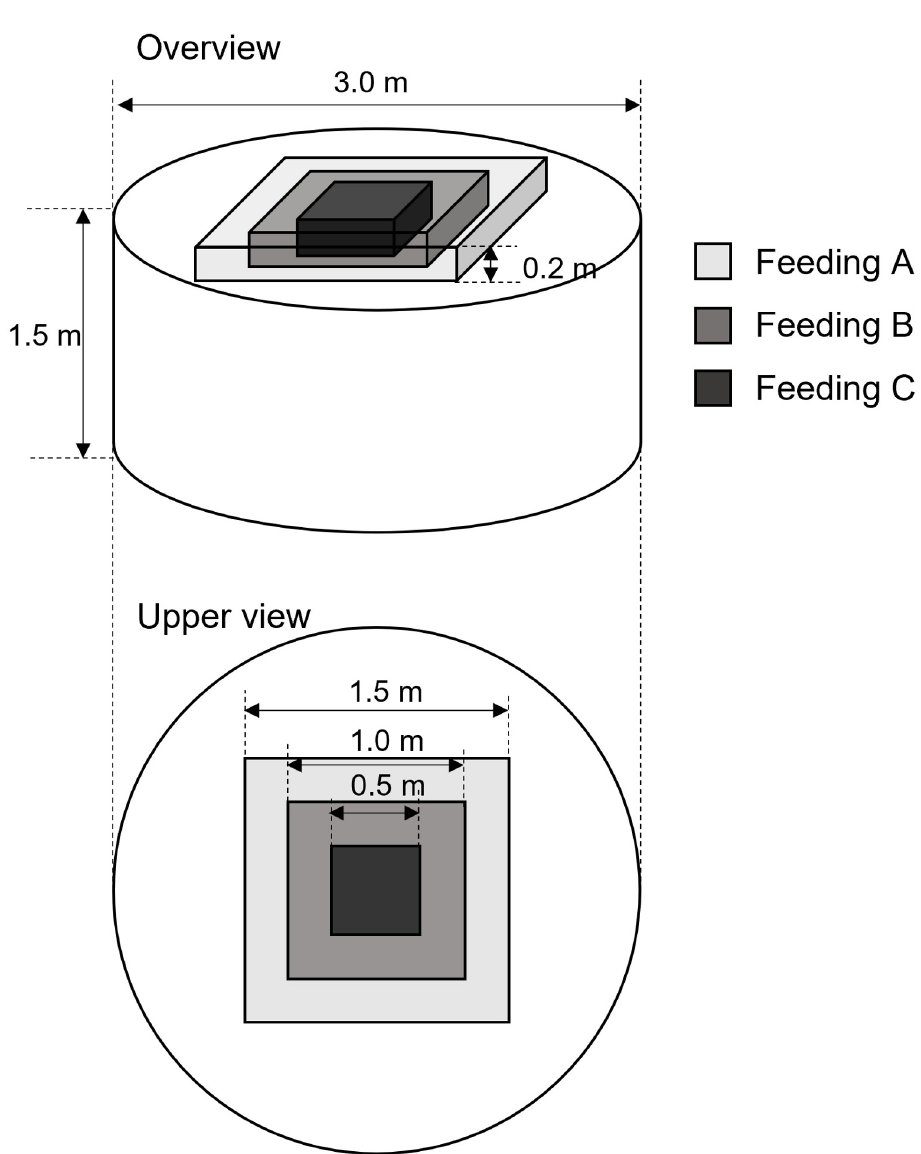
Fig 5. Simulation field. A 3.0-m diameter aquaculture tank with depth of 1.5 m was used with three feeding distributions in a square pattern: one side length was set to 1.5 m for the Feeding A, 1.0 m for the Feeding B, and 0.5 m for the Feeding C